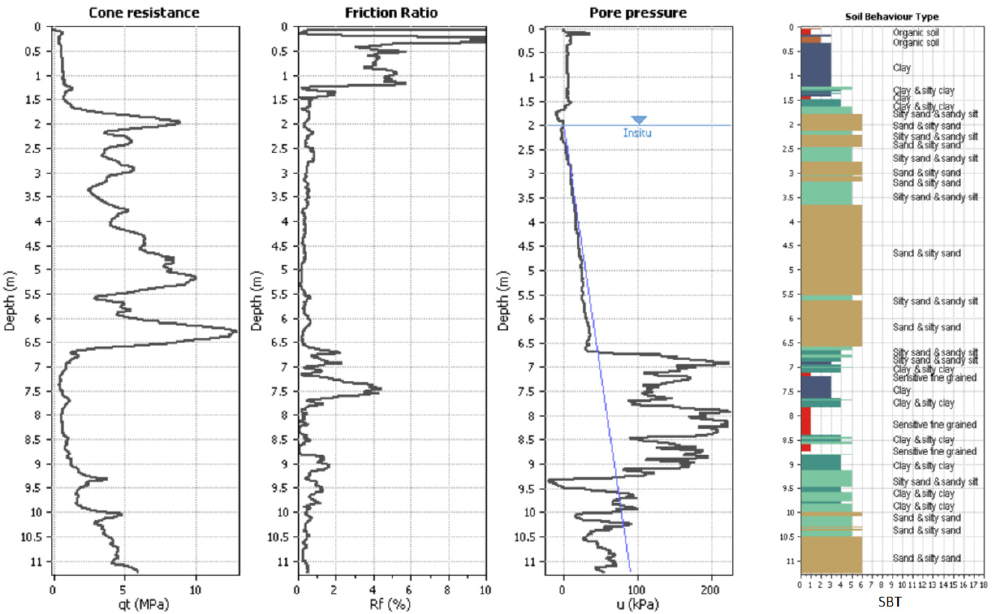
Figure 12. CPT characterization and SBT plot for Site 2-1 (after Anderson [40]).